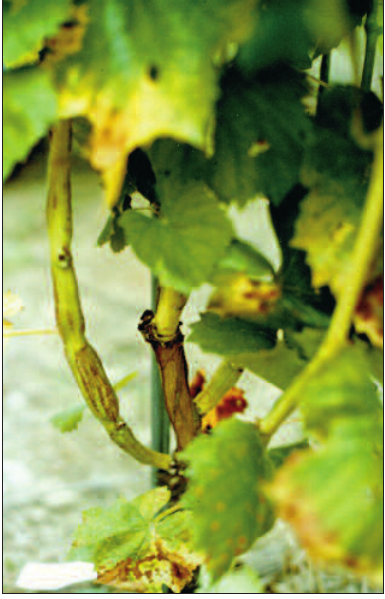
Figure 11. Corky bark (GVB) on the indicator LN33: swelling and grooving on shoot